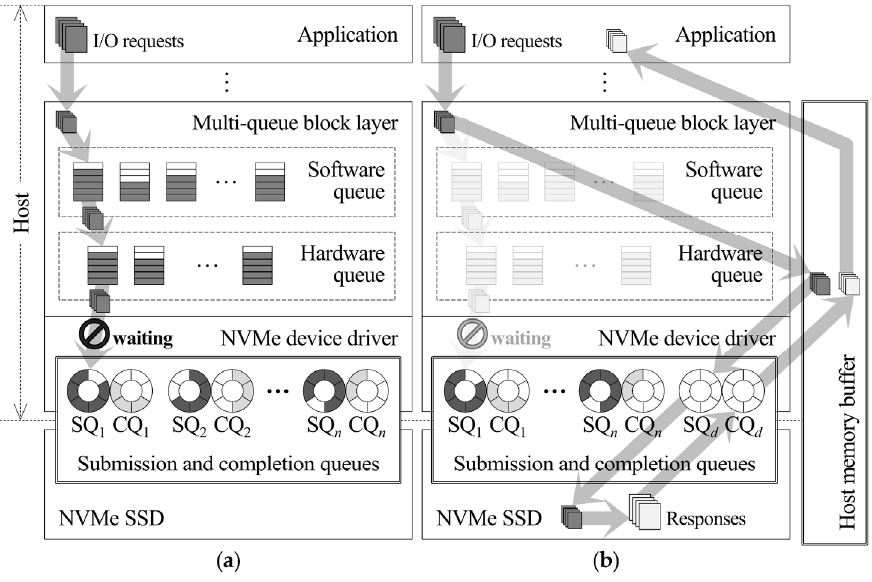
Figure 3. I / O handling via host memory bu ff er (HMB). ( a ) Normal I / Os; ( b ) urgent I / Figure 3. I/O handling via host memory buffer (HMB). ( a ) Normal I/Os; ( b ) urgent I/Os.